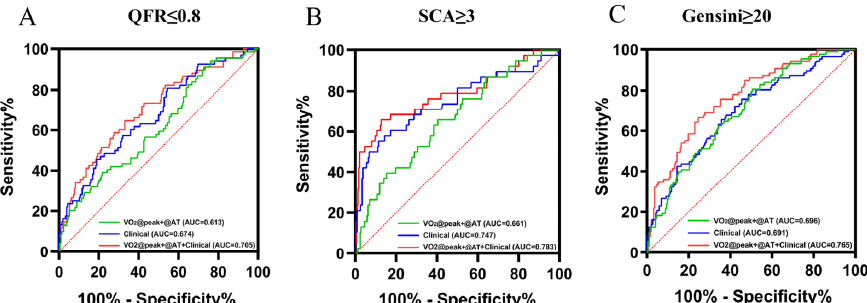
Figure 2. The area under the receiver–operator characteristic (ROC) curves are based on logistic regression models, incorporating conventional risk factors (including age, sex, BMI and history of smoking, hypertension, diabetes and hypercholesterolemia), with and without VO 2 @AT/VO 2prediction + VO 2 @peak/VO 2prediction . AUCs were calculated to distinguish the severe CAD and non ‐ severe CAD patients, measured by quantitative flow ratio (QFR). ( A ): the number of stenotic coronary arteries (SCA), ( B ): the Gensini score, and ( C ): VO 2 @AT—oxygen uptake at anaerobic threshold, and VO 2 @peak—peak oxygen uptake.